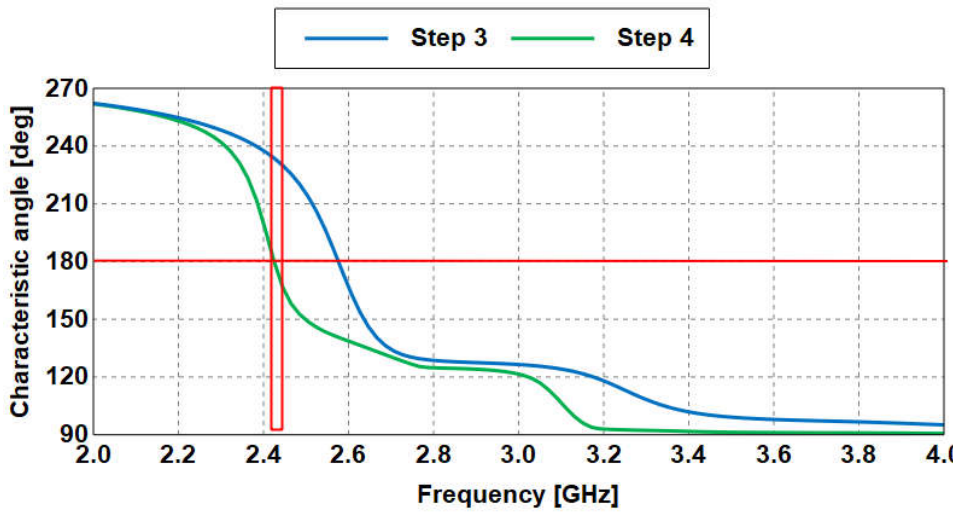
Figure 16. CA results of Steps 3 and 4 of the proposed design—mode 5.